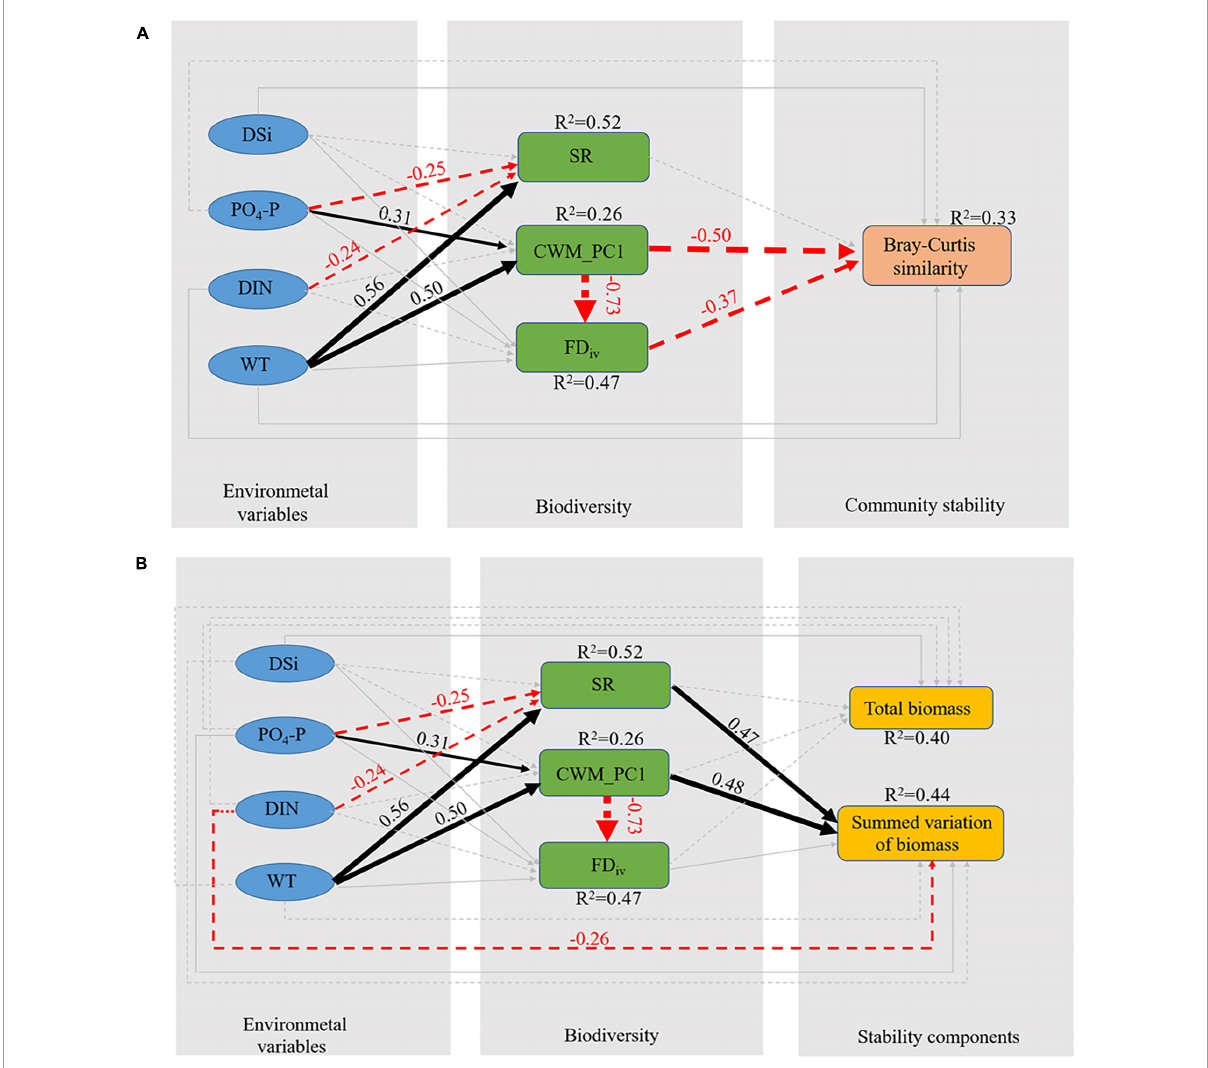
FIGURE4 Piecewise structural equation model (SEM) depicts the relationships between the environment variables, biodiversity and community stability (A) . Overall, the model fits the data well: Fisher’s C = 3.661, AIC = 59.661, and p -value = 0.454. Piecewise SEM depicts the relationships between the environment variables, biodiversity and community stability components (B) . The model fit the data well: Fisher’s C = 3.661, AIC = 79.661, and p -value = 0.454. The solid and dashed arrows represent positive and negative relationships, respectively, and the light-gray arrows represent non-significant relationships ( p > 0.05). Dissolved silicate (DSi), phosphate (PO 4 -P), dissolved inorganic nitrogen (DIN), water temperature (WT), phytoplankton species richness (SR), the first principal component of the community-weighted means of traits (CWM_PC1), functional divergence (FD iv ), Bray–Curtis similarity between phytoplankton community samples sampled in two adjacent weeks (Bray–Curtis similarity), the total biomass of phytoplankton samples from two adjacent weeks (Total biomass), summed variation of biomass of phytoplankton samples from two adjacent weeks (Summed variation of